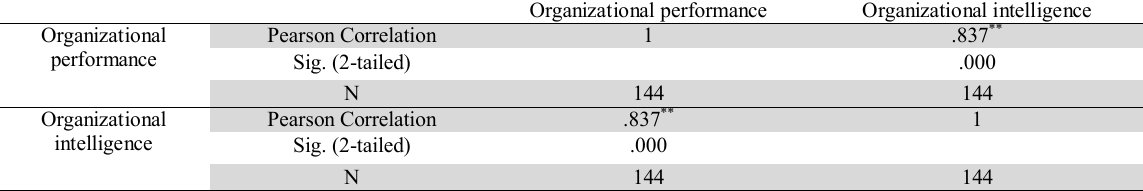
The results of relationship between organizational intelligence and organizational performance Organizational performance Organizational intelligence Organizational Pearson Correlation 1 .837 ** performance Sig. (2-tailed) .000 N 144 144 Organizational Pearson Correlation .837 ** 1 intelligence Sig. (2-tailed) .000 N 144 144